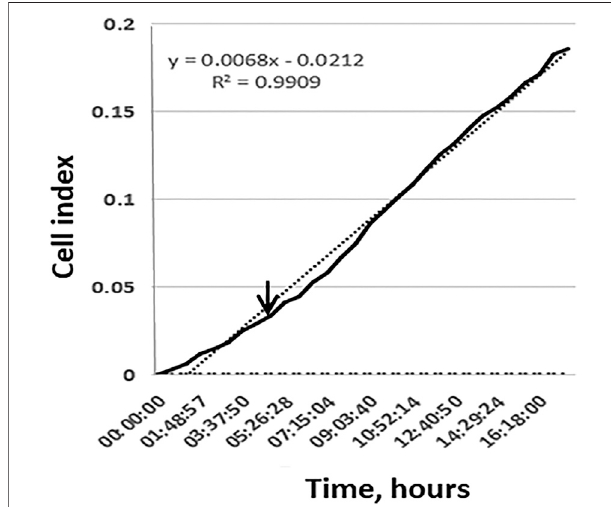
FIGURE 2 | The active migration of cells from MCTS seeded on plastic starts at time points 4 – 16 h. Representative image of the kinetic data for cell migration from single MCTS seeded on plastic generated by xCELLigence RTCA system. Dotted line represents a linear trend of the curve, dashed line corresponds to the background signal from the empty well. Expansion speed increases and overtakes the trend line at time point 3 – 4 h (indicated by arrow).